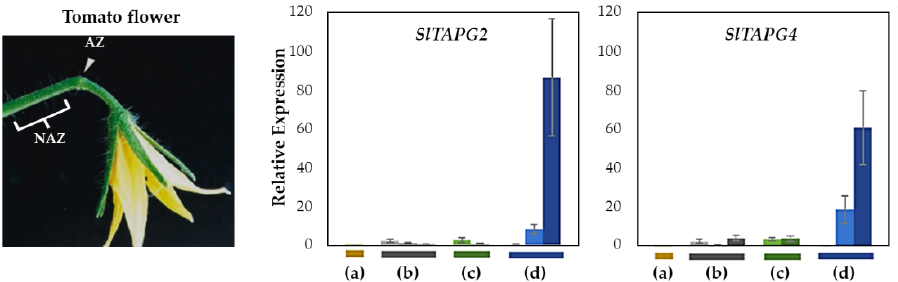
Figure 3. Relative gene expression of SlTAPG2, and SlTAPG4 for the AZ/NAZ in the four tomato variants. (a) jointless (j), (b) functionally impaired jointless (fij), (c) functionally impaired jointless like (fij like), and (d) normal joint (NJ). Except for the j (collected from only the midpoint), samples of AZ and NAZ (proximal side of pedicel) from several flower developmental stages available on the peduncle of the variant that covers a relatively broad range of flower abscission development were collected (Figure S1). One developmental stage of j, three developmental stages of fij, two developmental stages of fij like, and three developmental stages of NJ were collected. The samples from two neighboring peduncles on the primary inflorescence were utilized and combined for the respective developmental stages of AZ and NAZ samples from each peduncle to enrich the samples for RNA extraction. Each bar graph (AZ/NAZ), except for the j, of the natural abscission variant, represents the result from those several flower abscission developmental stages. The means ± SD of three independent replicates were used to present data sets.